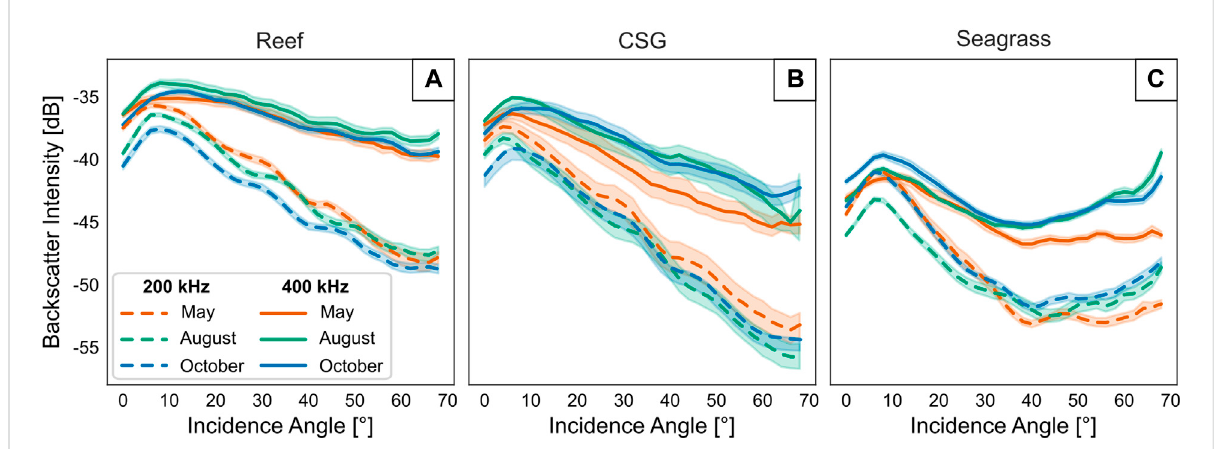
FIGURE 9 Angularrangecurves(ARCs)at200and400 kHzfrequencyforthe3 monthswithinthethreefacies:reef (A) ,CSG (B) ,andseagrass (C) .Dataare extracted from the respective facies details presented before (Figure 2B for locations). A 95%-con fi dence interval was added to the